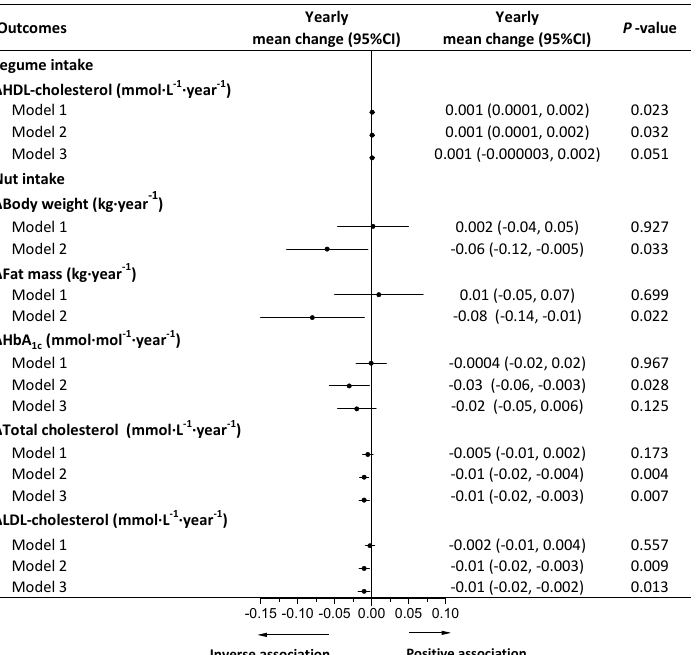
Figure 3. Longitudinal associations of legume (10 g · day − 1 ) or nut (5 g · day − 1 ) intake with yearly weight regain and changes in cardiometabolic risk factors during weight-loss maintenance. Yearly mean change and 95% CI of main effects indicating changes in body weight or cardiometabolic risk factors per year associated with 10 g increment in legume intake or 5 g increment in vegetable intake. Analyses were conducted using a linear mixed model with repeated measures. Model 1 was adjusted for fixed factors including age, sex, ethnicity, BMI at 8 weeks, body weight, or cardi- ometabolic risk factors at 8 weeks and time and random factors including study center and partici- pant ID. Model 2 was adjusted for covariates in model 1 plus fixed factors including time-varying physical activity, energy intake (kJ·day − 1 ), alcohol intake (g·day − 1 ), animal-based food intake (g·day − 1 ), and other plant food intake (g·day − 1 ). Model 3 was adjusted for covariates in model 2 plus time-varying yearly changes in body weight as a fixed factor. HbA 1c , glycosylated hemoglo- bin A 1c ; HDL cholesterol, high-density lipoprotein cholesterol; LDL cholesterol, low-density lipo- protein cholesterol.